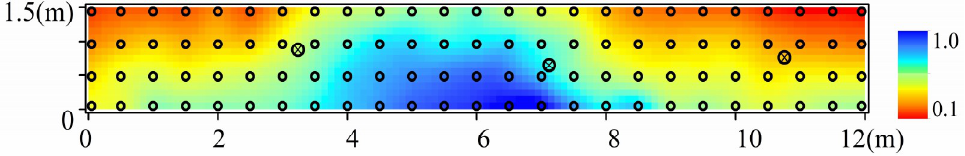
Figure 2. Spatial distribution of simulated rainfall over the soil tank from the upside (left) to the downside (right). (Note: black circles are locations of the cups, and circles with cross are rain gauges).